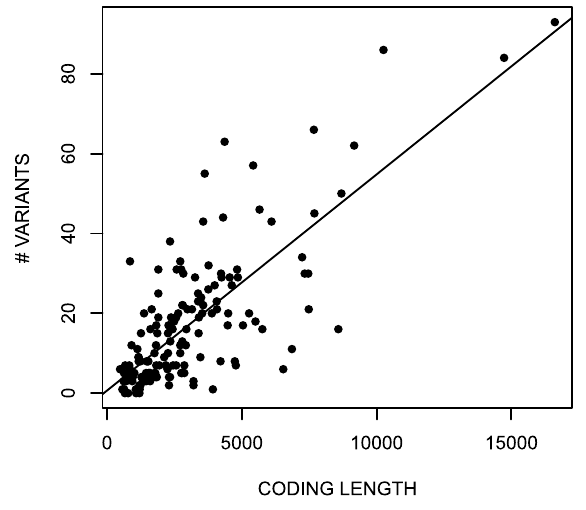
Figure 5. Correlation between the number of variants and coding length. The number of nonsynonymous variants vs. total number of coding bases for each of the 158 cancer-susceptibility genes.